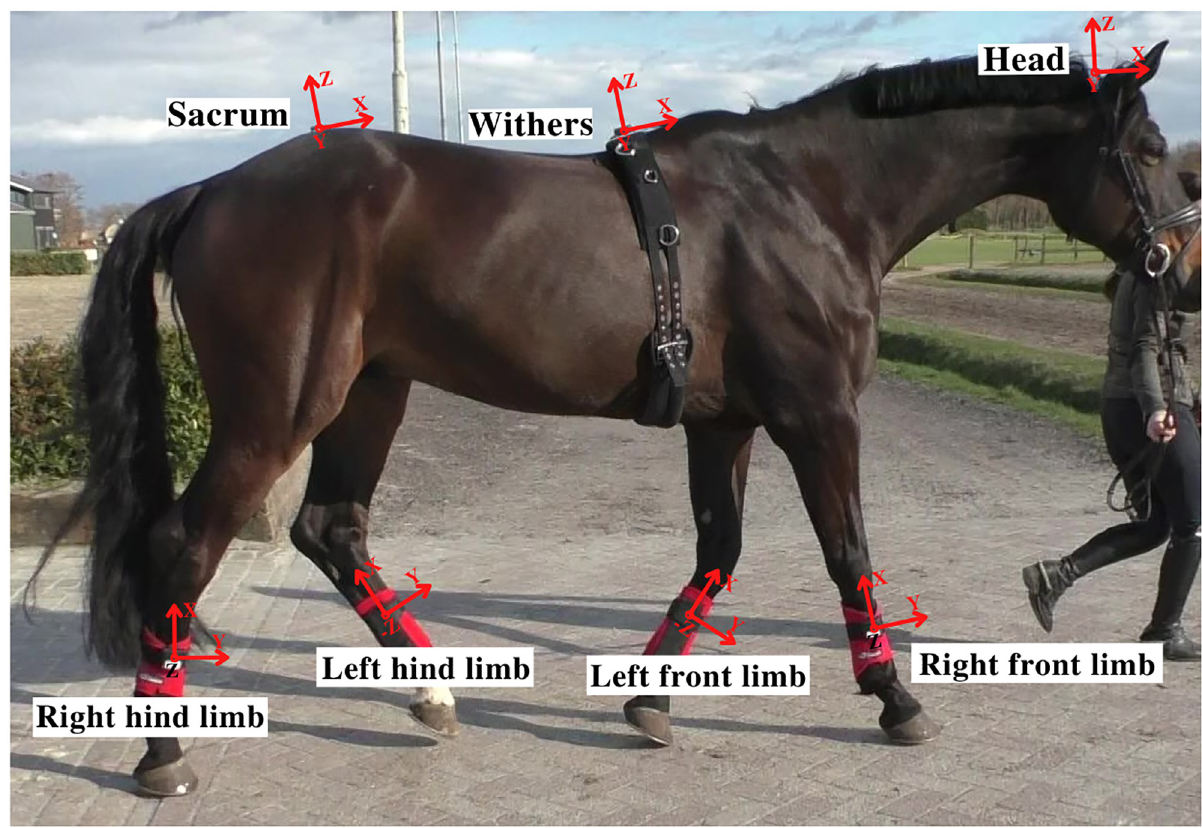
Fig 3. IMUs locations and orientations on horse